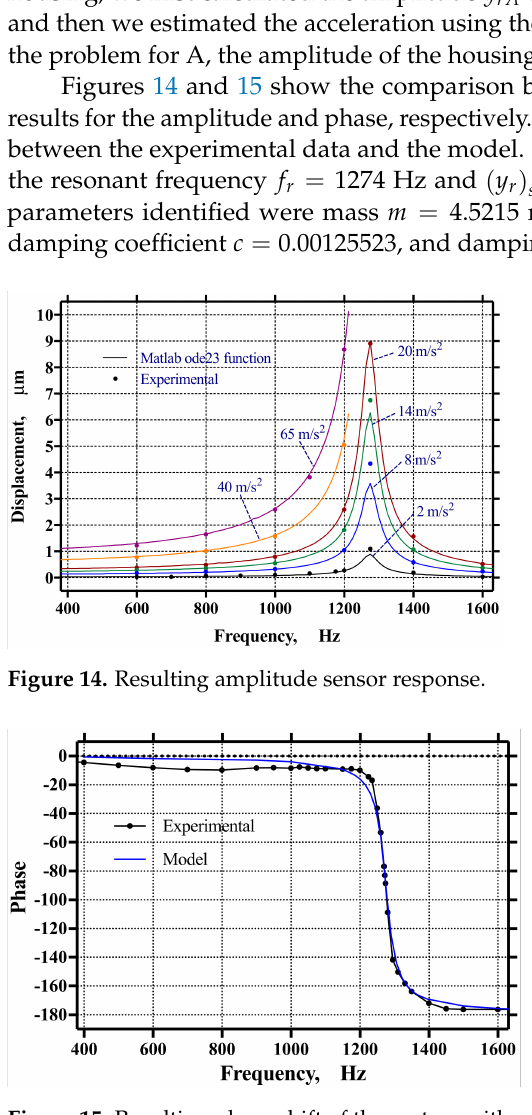
Figure 15. Resulting phase shift of the system with a 90-degree shift located a 1274.5